Question: What visual encoding does this figure use to show its data?
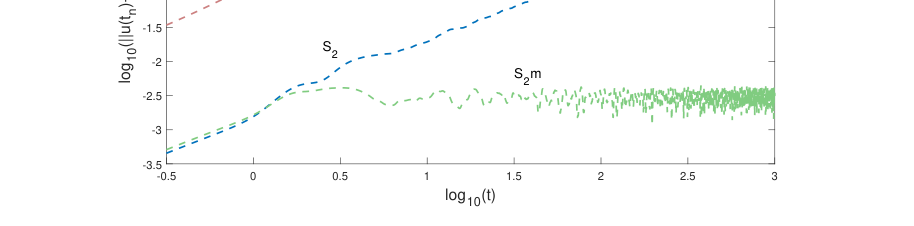
Answer: line